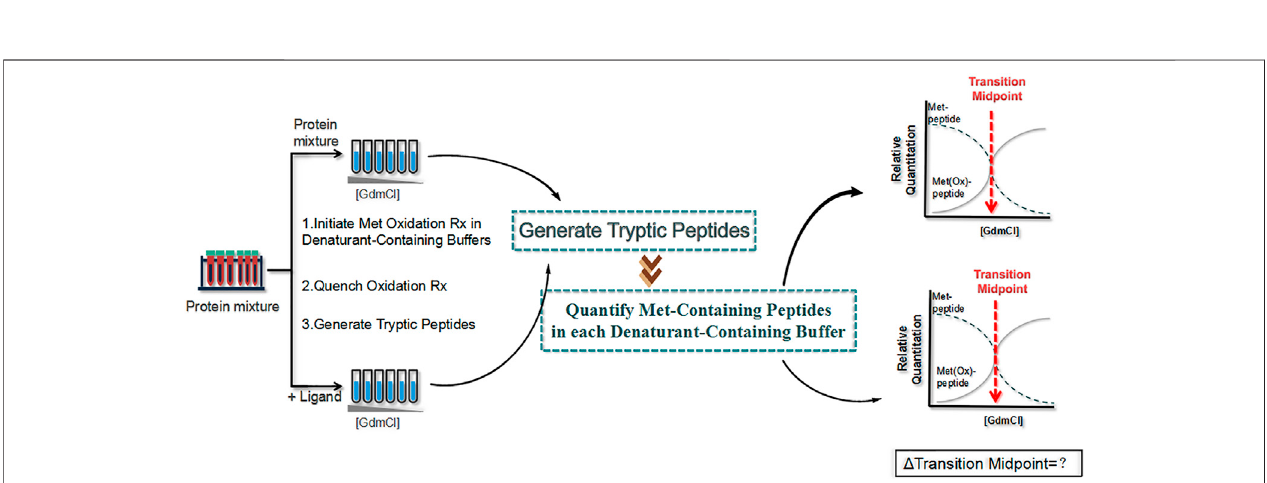
FIGURE 9 | Schematic diagram of the stability of proteins from rates of oxidation (SPROX) strategy. First, two protein samples (with and without ligand) are dispensed into a buffer containing a chemical denaturant , and hydrogen peroxide is added to the protein sample. Then, the oxidation reaction is quenched with an excess of methionine, and the protein sample is precipitated with tricarboxylic acid for subsequent quantitative proteomics to obtain the oxidation ratio of oxidized methionine.